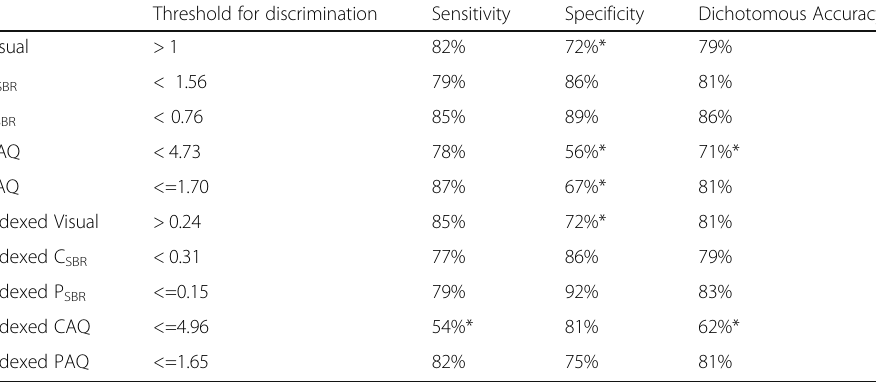
Table 2 ROC result for discriminating patients with ET from those with PD Threshold for discrimination Sensitivity Specificity Dichotomous